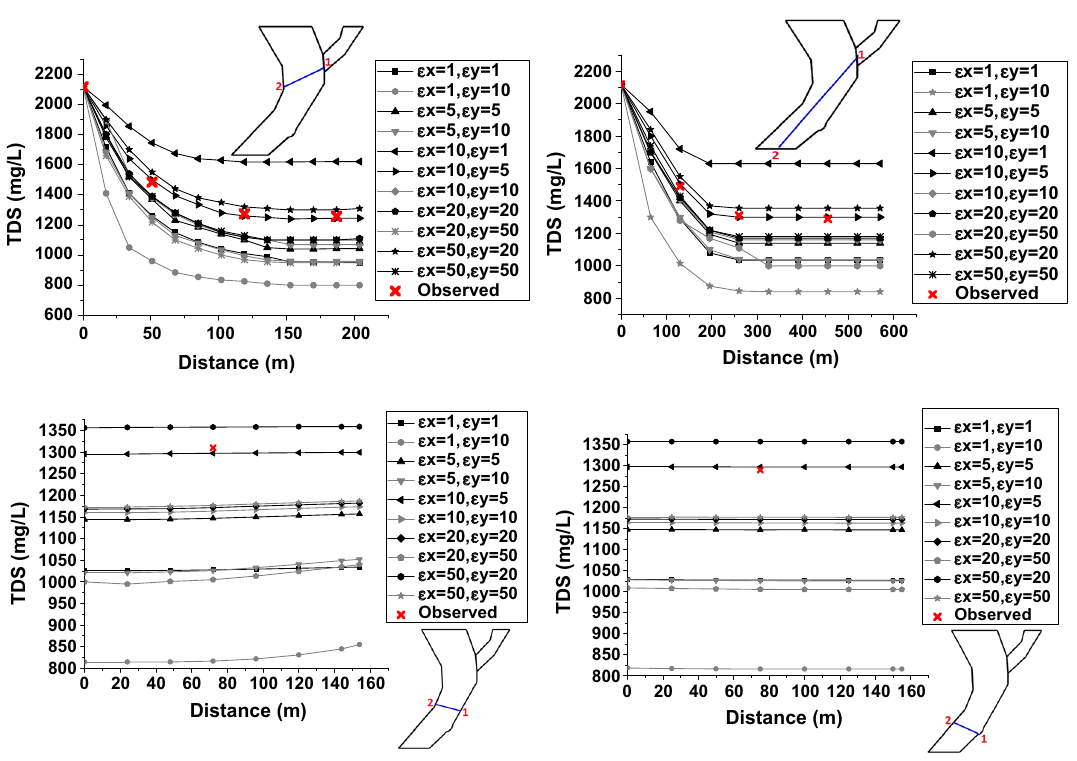
Fig. 3 Calibration results of TDS concentrations along Diyala River confluence with Tigris (June